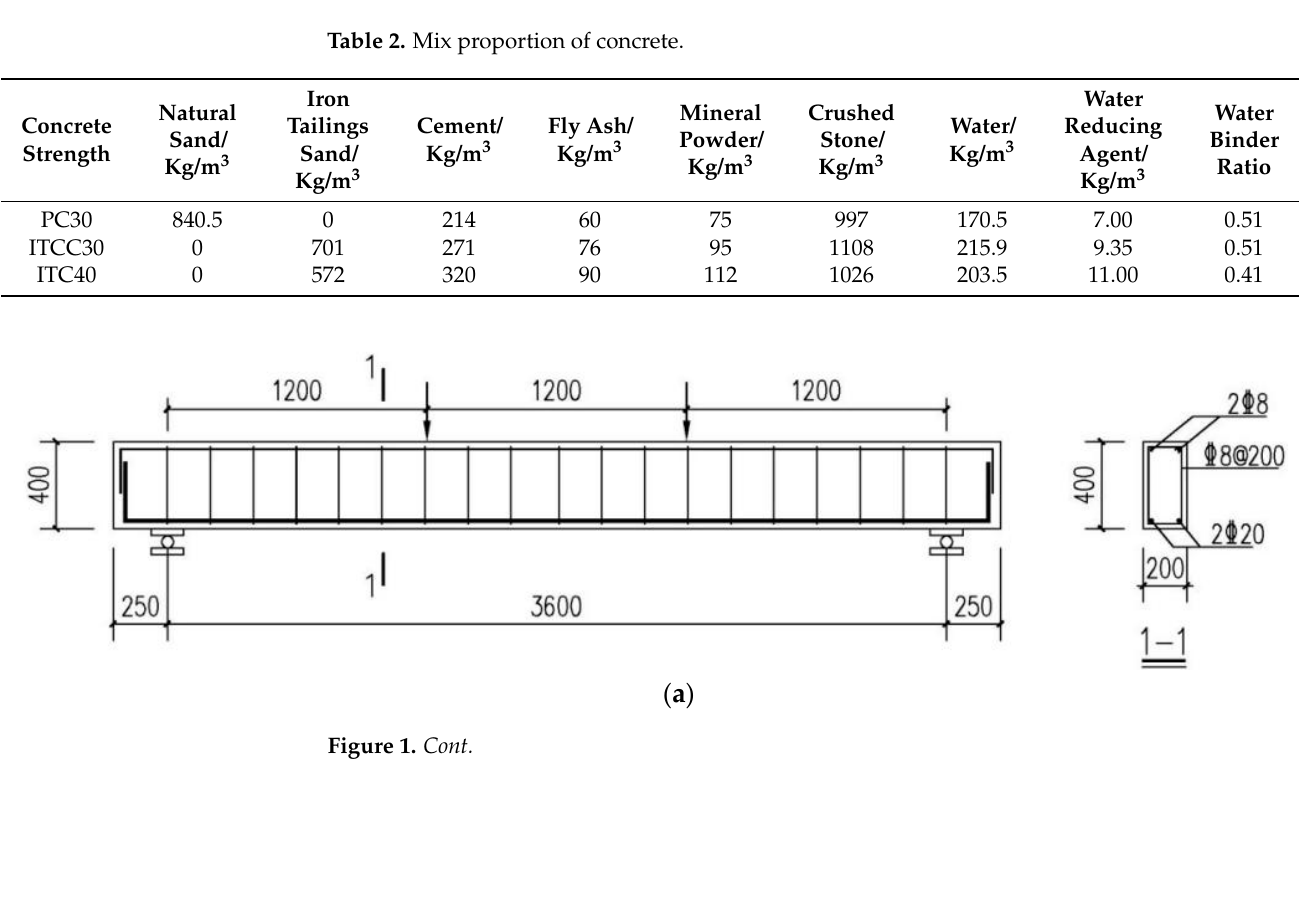
Table 1. Design parameters of beams.